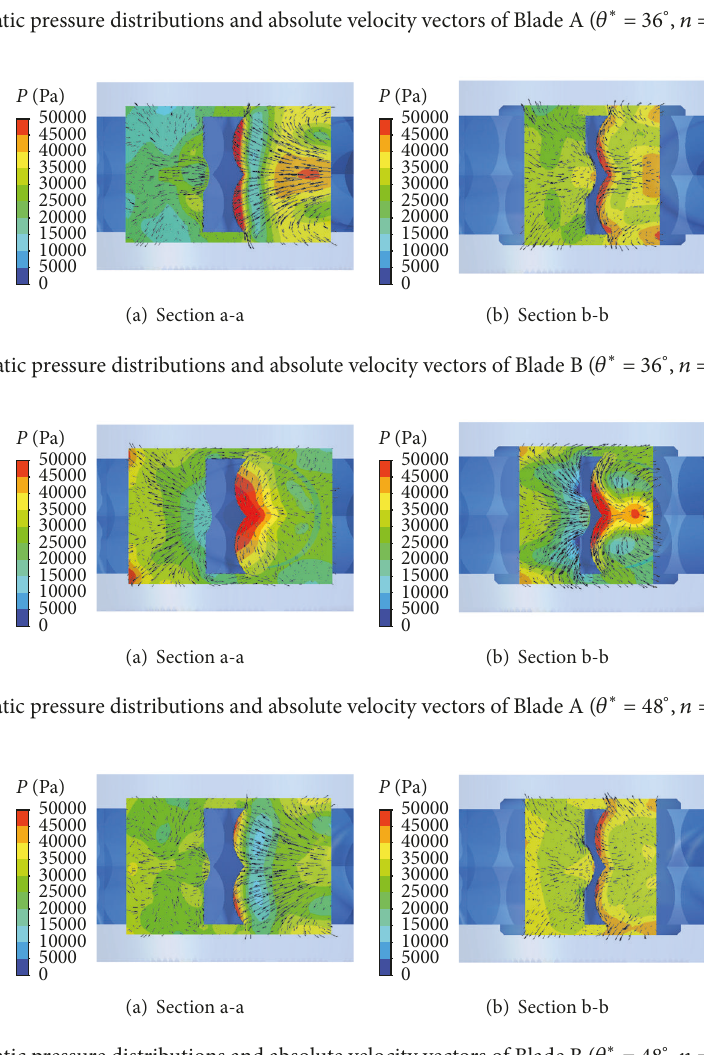
Figure 30: Static pressure distributions and absolute velocity vectors of Blade B ( 𝜃 ∗ = 48 ∘ , 𝑛 = 400 ,000 min −1